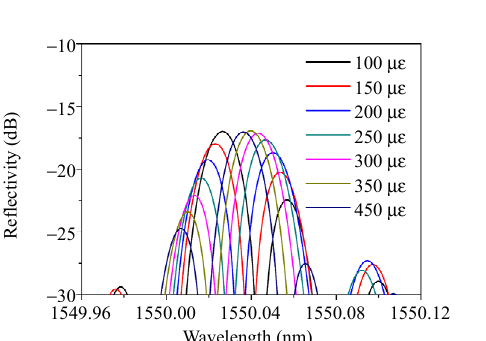
Fig. 9 Change of the central reflection peaks with different strains.